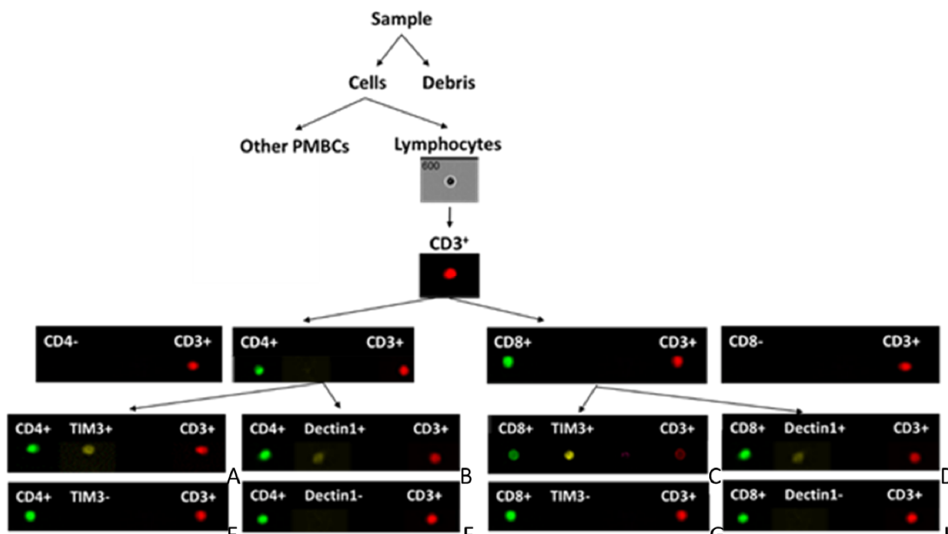
Figure 1. Flow cytofluorimetric analysis workflow. The image shows the sequential procedure and the microphotographs of stained cells ( A – H ) using five different monoclonal fluorescent dye-coupled anti-human antibodies and analysed by flow cytometry (Amnis FlowSight). For each patient, four aliquots of lymphocyte suspensions (100 µL) were stained with antibodies using four different combinations (10 µL of each antibody). Representative stained cells (event) for each of the four combinations are shown: CD-3 + CD-4 + TIM-3 + ( A ); CD-3 + CD-4 + Dectin-1 + ( B ); CD-3 + CD-8 + TIM-3 + ( C ); CD-3 + CD-8 + Dectin-1 + ( D ). Tim3 − and Dectin-1 − cells are also shown: CD3 + CD-4 + TIM-3 − ( E ); CD-3 + CD-4 + Dectin-1 − ( F ); CD-3 + CD-8 + Tim3 − ( G ); CD-3 + CD-8 + Dectin-1 − ( H ).